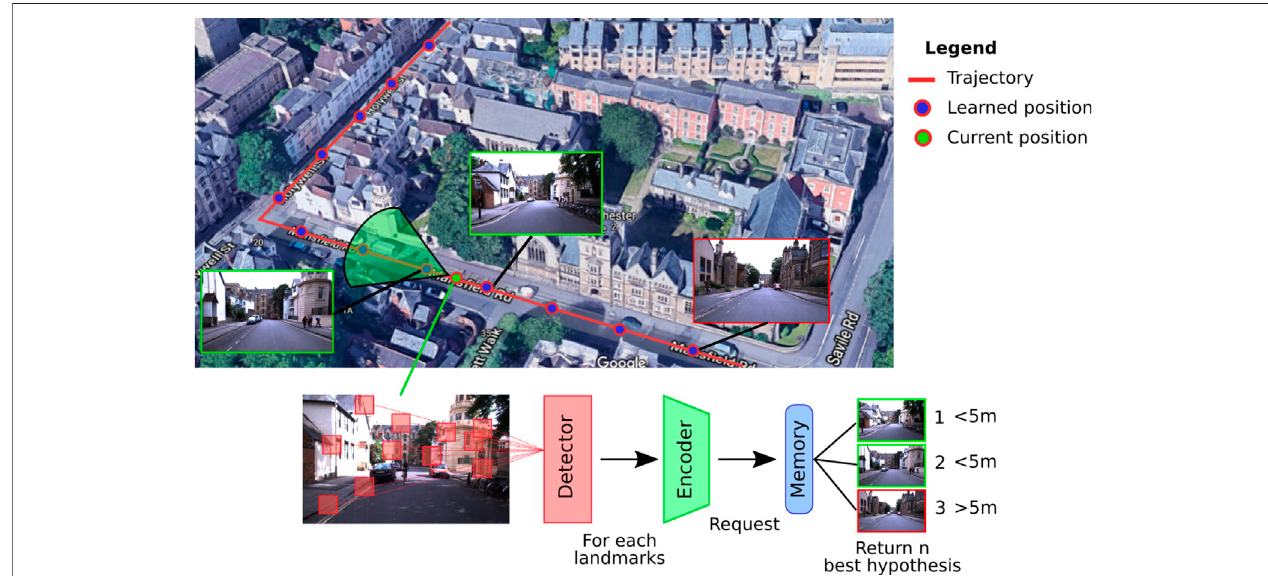
FIGURE 1 | Illustration of a classic visual place recognition (VPR) operation. A VPR system can be decomposed into three functional blocks: 1) a detector that selects the signi fi cant information of the acquired image; 2) an encoder that compresses the useful information; and 3), a memory that contains the places in a memory formatsuitableforthequerysystem.The fi nalcodeisusedtodeterminefromthecurrentimageofthevehicleinwhichplaceitislocatedbyextrapolatingitspositionfrom the responses of the